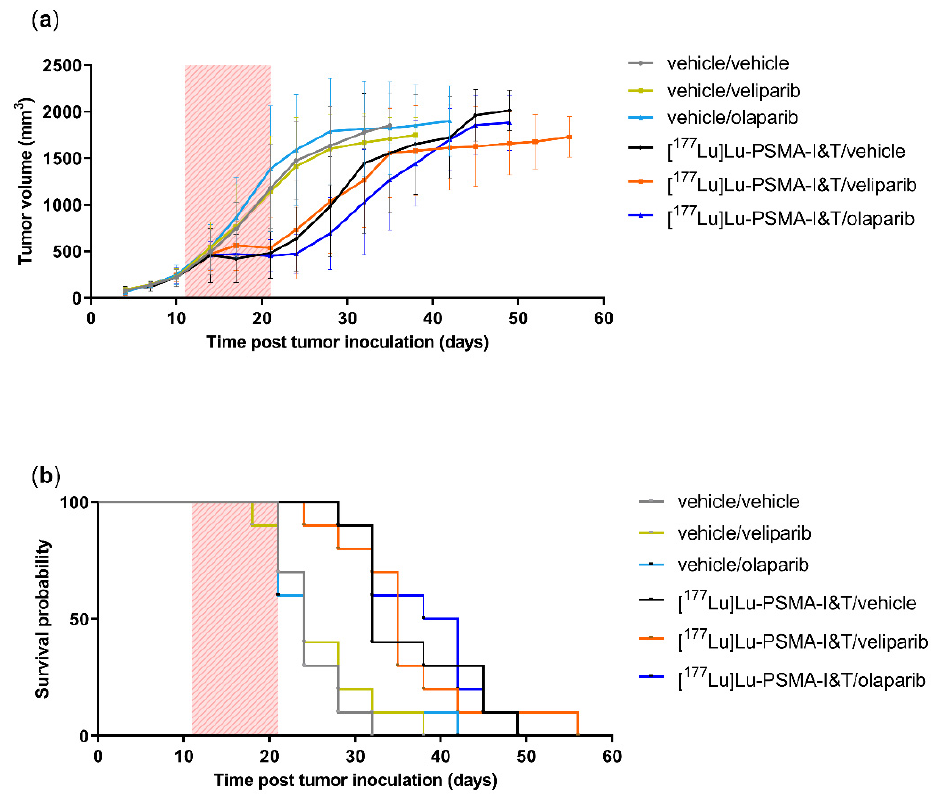
Figure 3. In vivo valuation of [ 177 Lu]Lu-PSMA-I&T effectivity in combination with PARPi. ( a ) Aver- age tumor volume and ( b ) survival probability. The red box indicates the treatment period with one injection of [ 177 Lu]Lu-PSMA-I&T or vehicle at day 11 and subsequent daily dosing by oral gavage of the PARPi or vehicle from day 11 until day 21. Error bars indicate standard deviation. The tumor growth of each individual animal can be found in Supplementary Materials Figure S2.